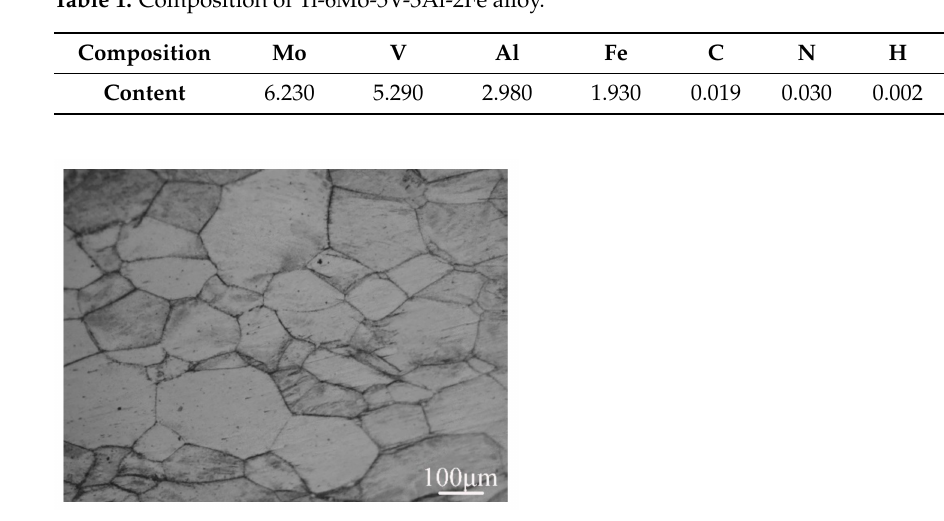
Figure 1. Microstructure of Ti-6Mo-5V-3Al-Fe alloy before hot compression. The sample used in the thermal simulation compression experiment was a cylindrical sample cut from the Ti-6Mo-5V-3Al-2Fe alloy billet. The sample size was 10 mm in